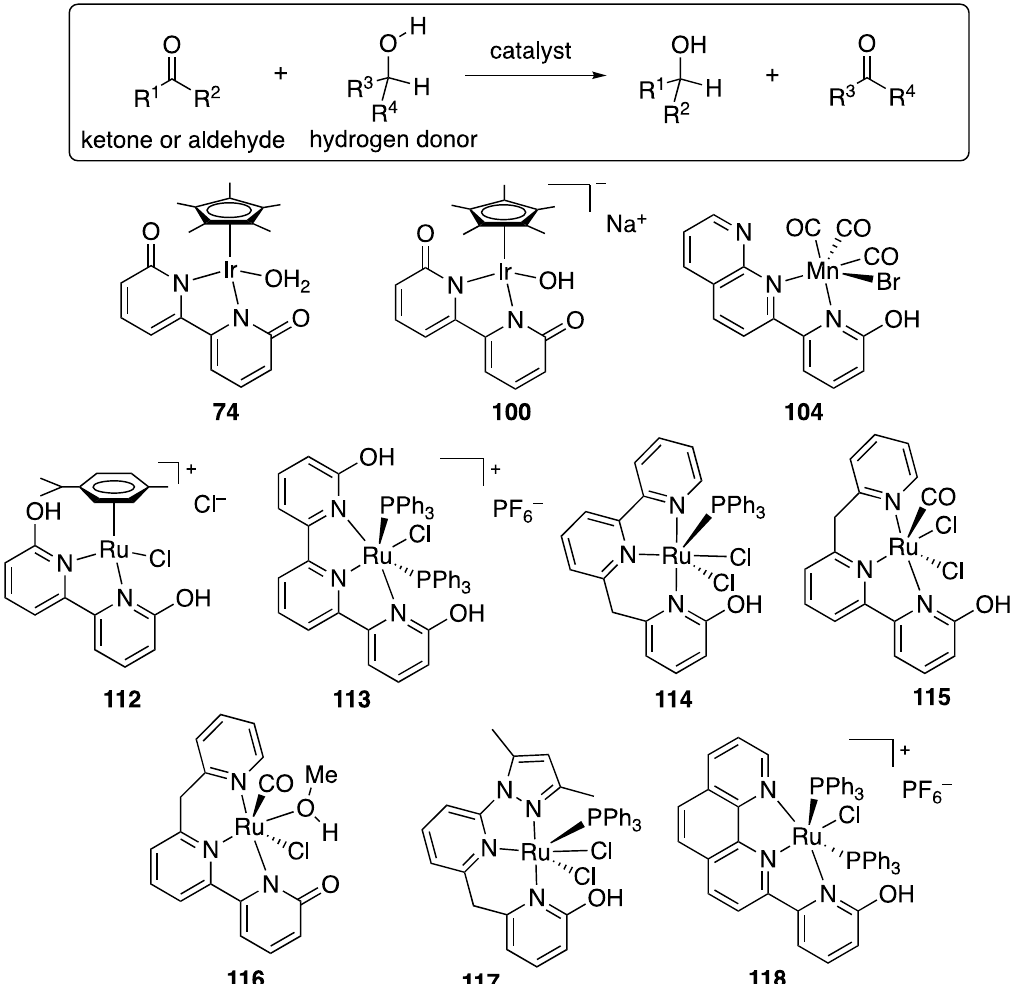
Figure 6. Reported catalysts bearing hydroxypyridine-based ligands for the transfer hydrogenation of carbonyl